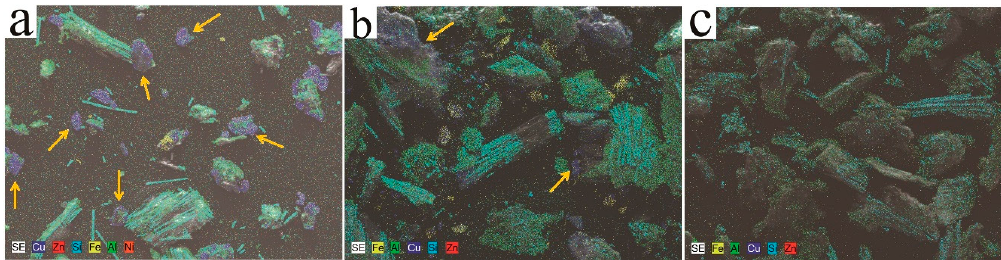
Figure 9. FT-IR of residual material retrieved after copper bioleaching from WPCBs. ( a ) Original WPCB powder and ( b ) WPCBs for residues containing 2.5 g/L graphite.